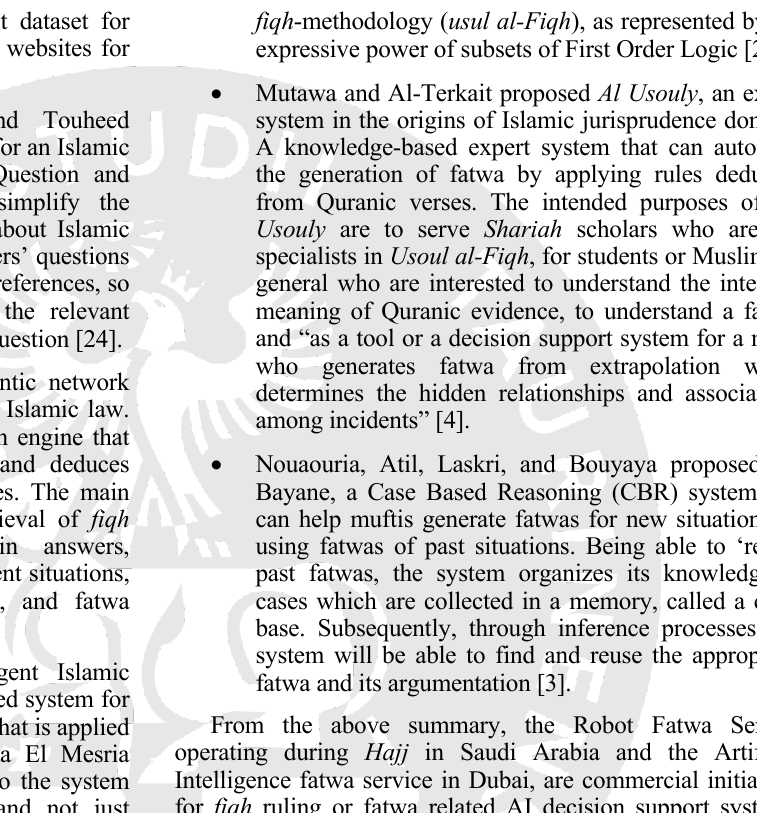
a generic algorithm for deciding Fiqh rulings with full transparency and complete algorithmic coverage